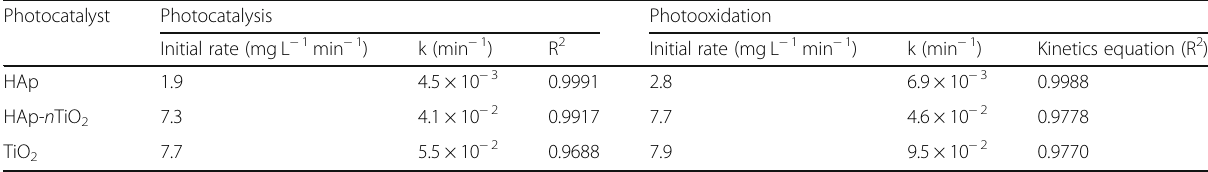
Table 2 Kinetics equation and parameters of MV photocatalysis and photooxidation using varied photocatalysts